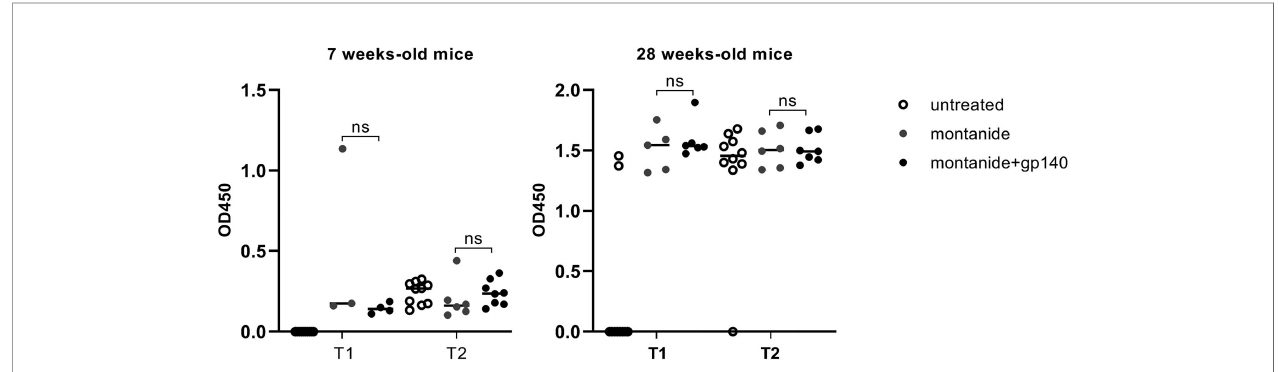
FIGURE 4 | Gp140-speci fi c IgG titers are shown at 7 days p.i. (T1) and 14 days p.i. (T2) in untreated, montanide or montanide+gp140-treated 7 weeks-old and 28 weeks-old C57BL/6 EAE mice. p-values were calculated using two-way ANOVA test (ns, not signi fi